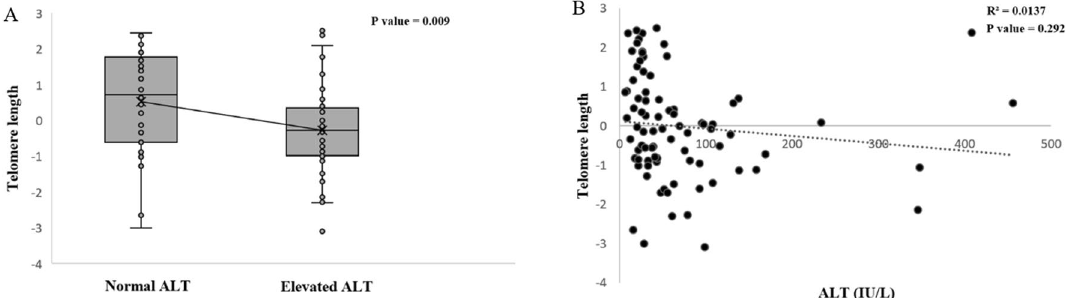
Figure 4. Correlation between telomere length and fibrosis stage. Telomere length was decreased along with increasing fibrosis severity in NAFLD patients ( p = 0.028); NAFLD non-alcoholic fatty liver